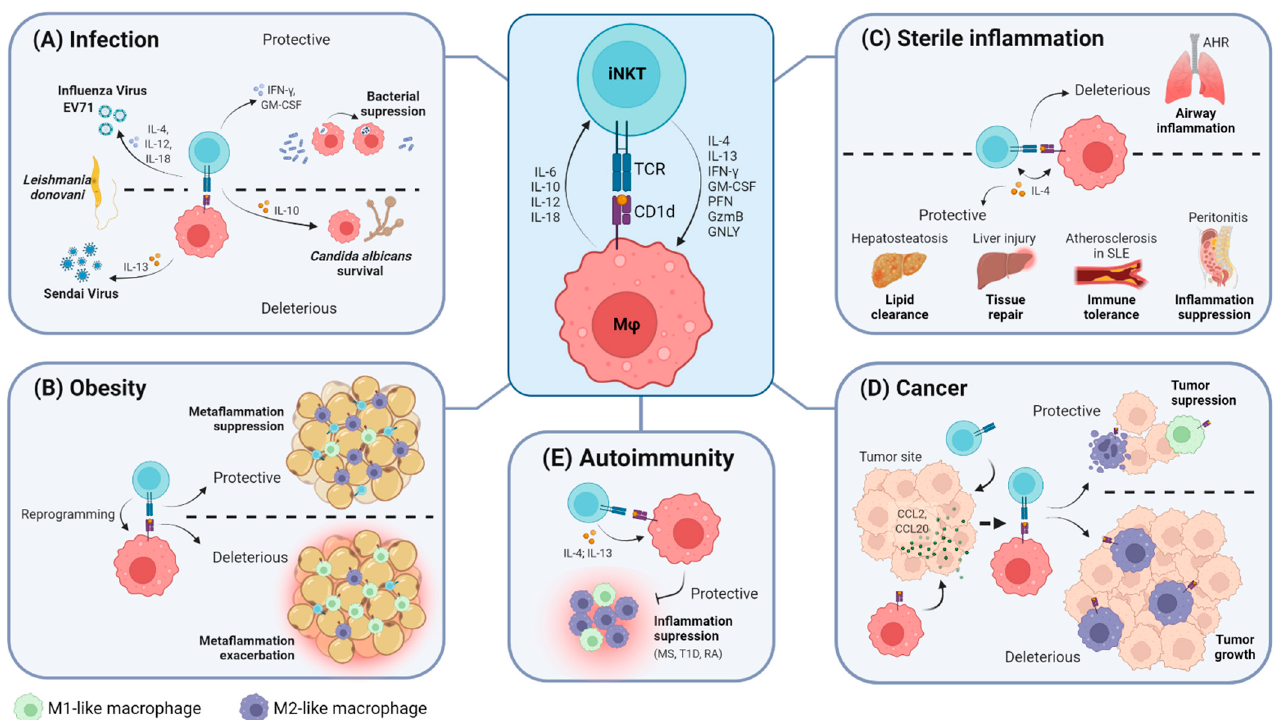
Figure 1. iNKT cells and macrophages interact under different pathological contexts. This crosstalk primarily involves the recognition of antigen-loaded CD1d molecules by the iNKT cell TCR, followed by the exchange of cytokines and the interplay of other effector molecules that are specific to each paradigm. ( A ) The outcome of interactions between iNKT cells and macrophages in infectious environments. ( B ) The outcome of interactions between iNKT cells and macrophages in obesity. ( C ) iNKT cells and macrophages interact differently under distinct sterile inflammatory conditions. ( D ) The iNKT cell–macrophage axis in the context of cancer. ( E ) The outcome of the interplay between iNKT cells and macrophages in autoimmunity. Created with BioRender.com in 22 January, 2022. PFN: perforin; GzmB: granzyme B; GNLY: granulysin; MS: Multiple sclerosis; T1D: type I diabetes; RA: rheumatoid arthritis.